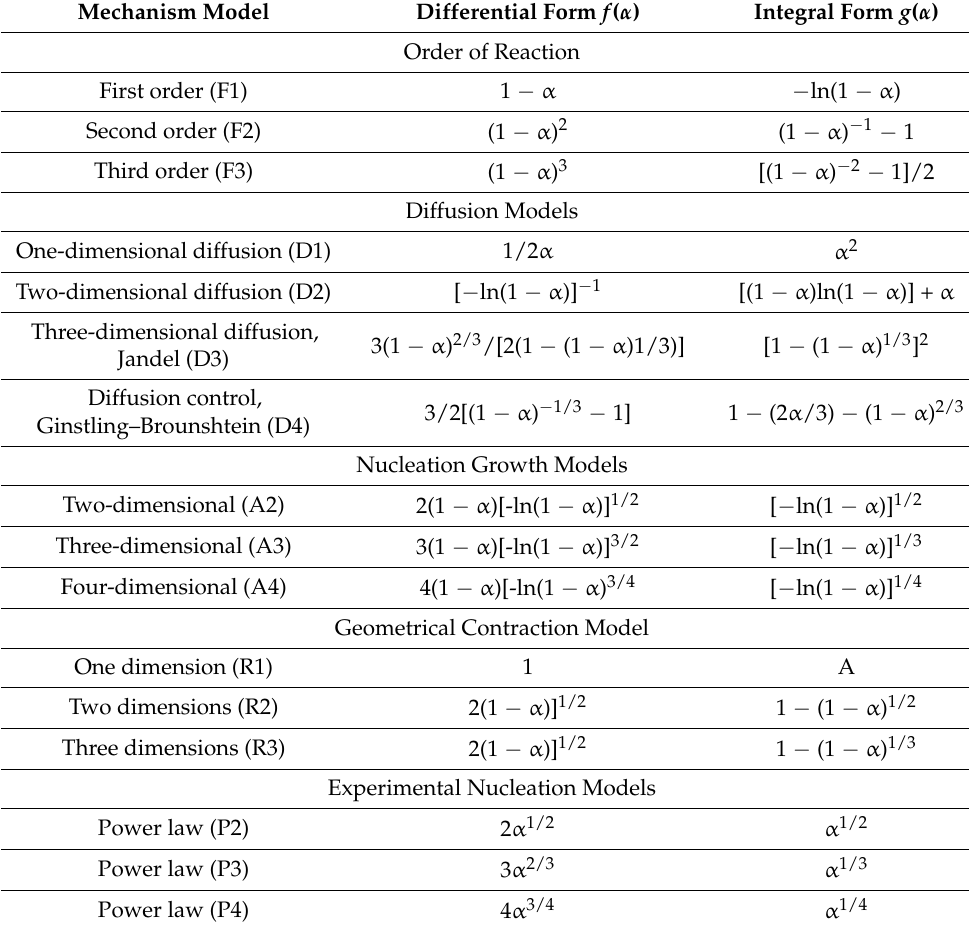
Table 4. Thermal kinetic models for solid-state kinetics with expression for f ( α ) and g ( α ). Mechanism